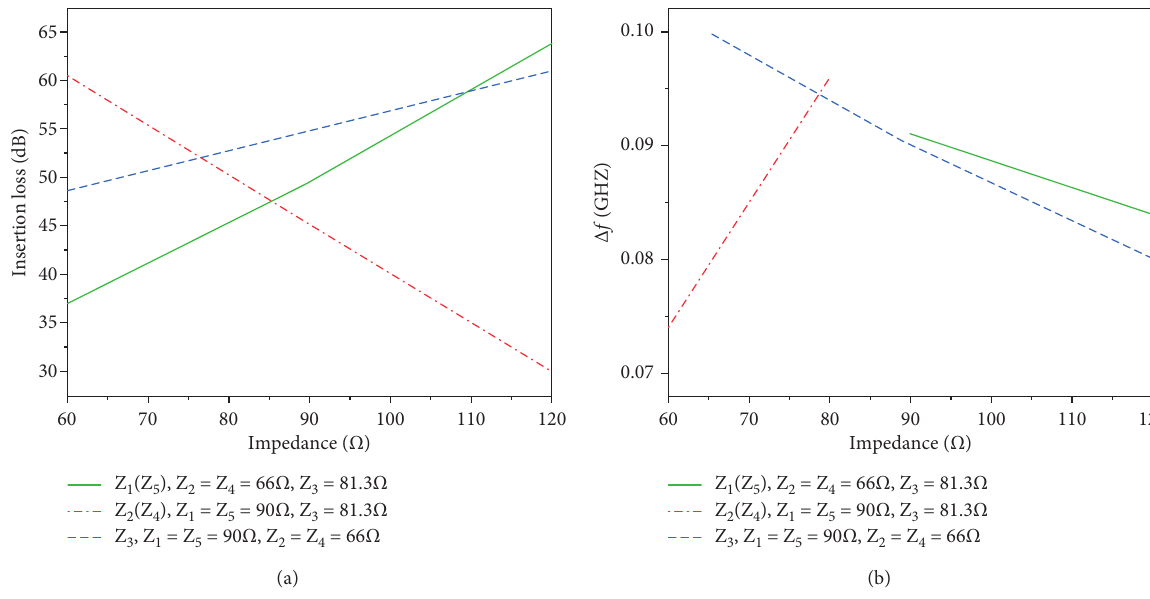
Figure 6: Simulation analysis: (a) the relationship between Z 1 ( Z 5 ), Z 2 ( Z 4 ), Z 3 and maximum insertion loss; (b) the relationship between